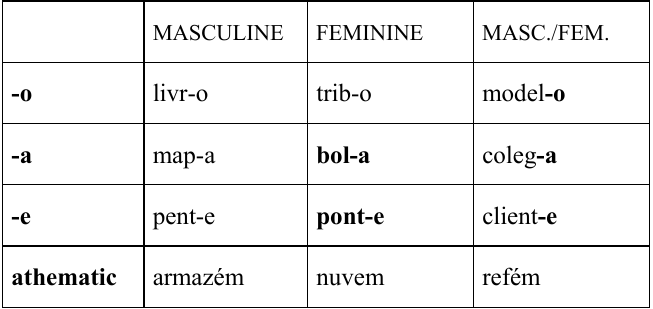
Table I: Formal classes of nouns and gender (based on: Alcântara, 2003) MASCULINE FEMININE